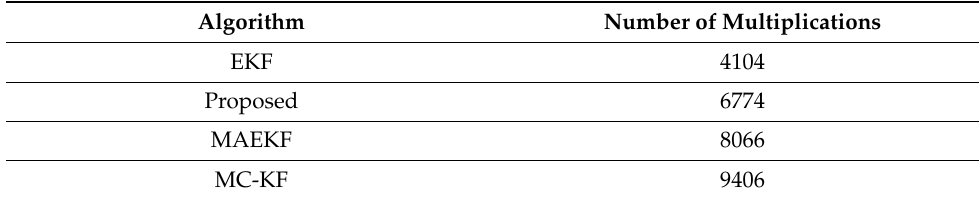
Table 3. Comparison of number of multiplications.